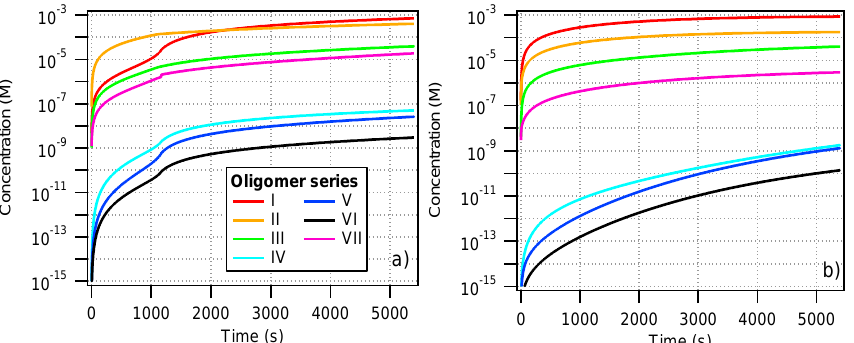
Figure 5. Comparison of predicted evolution for individual oligomer series I–VII (Fig. 1) for [MVK] 0 = 20mM for (a) high (saturated) and (b) low initial oxygen